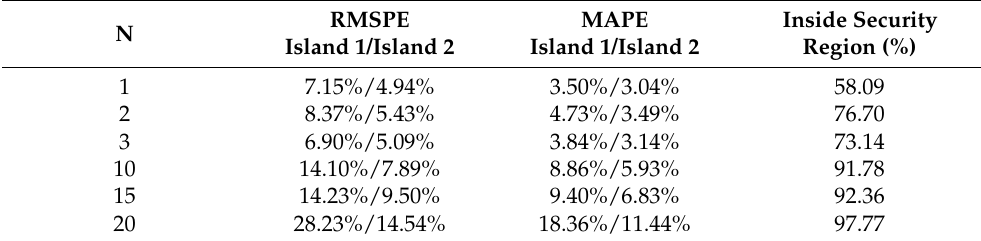
Table 4. Prediction errors with different penalizing